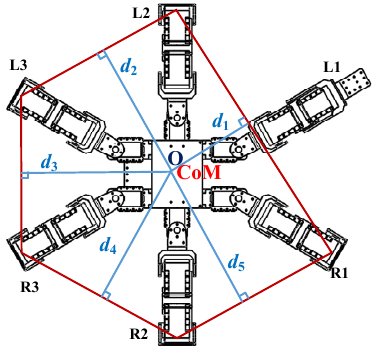
Figure 11. The stability margin of the wave gait.